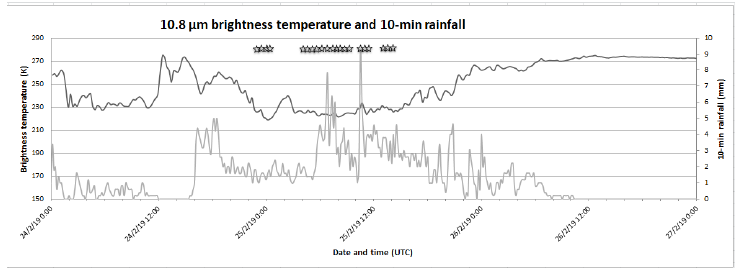
Figure 14. Time evolution of 10.8 µ m brightness temperature (at 15-min intervals) and of 10-min accumulated rainfall at Askyfou area, during the 3-day period, starting at 0000 UTC 24 February 2019. Stars at the top of the diagram indicate the time periods of convective activity.